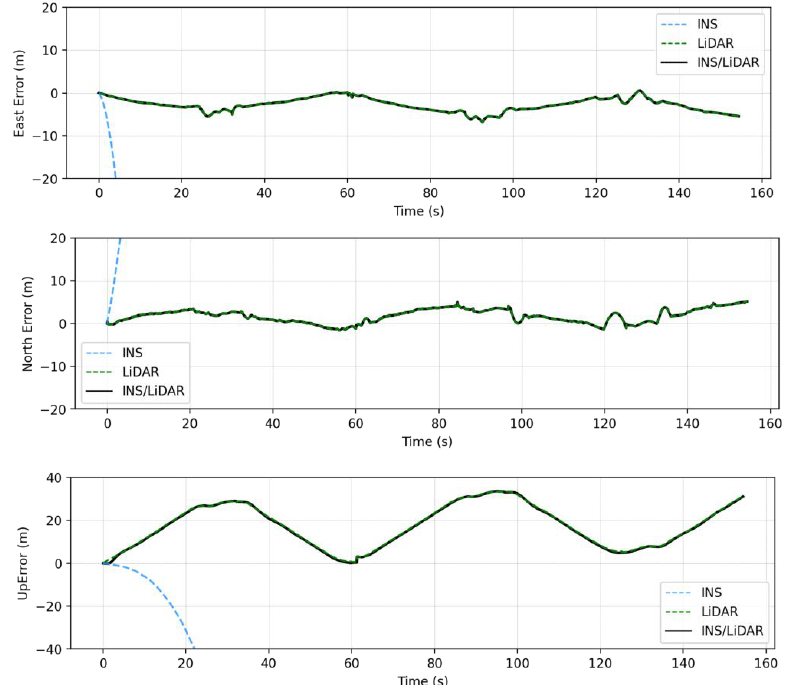
Figure 10. Complete GNSS signal outage: position errors (ENU).